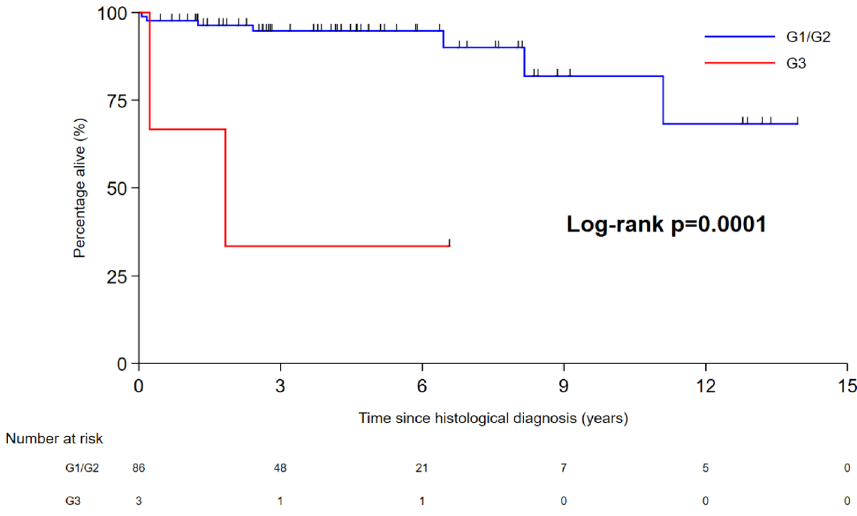
Figure 1. Kaplan–Meier survival curve for dNENs using a Ki67 cut-off of 20% (G3).